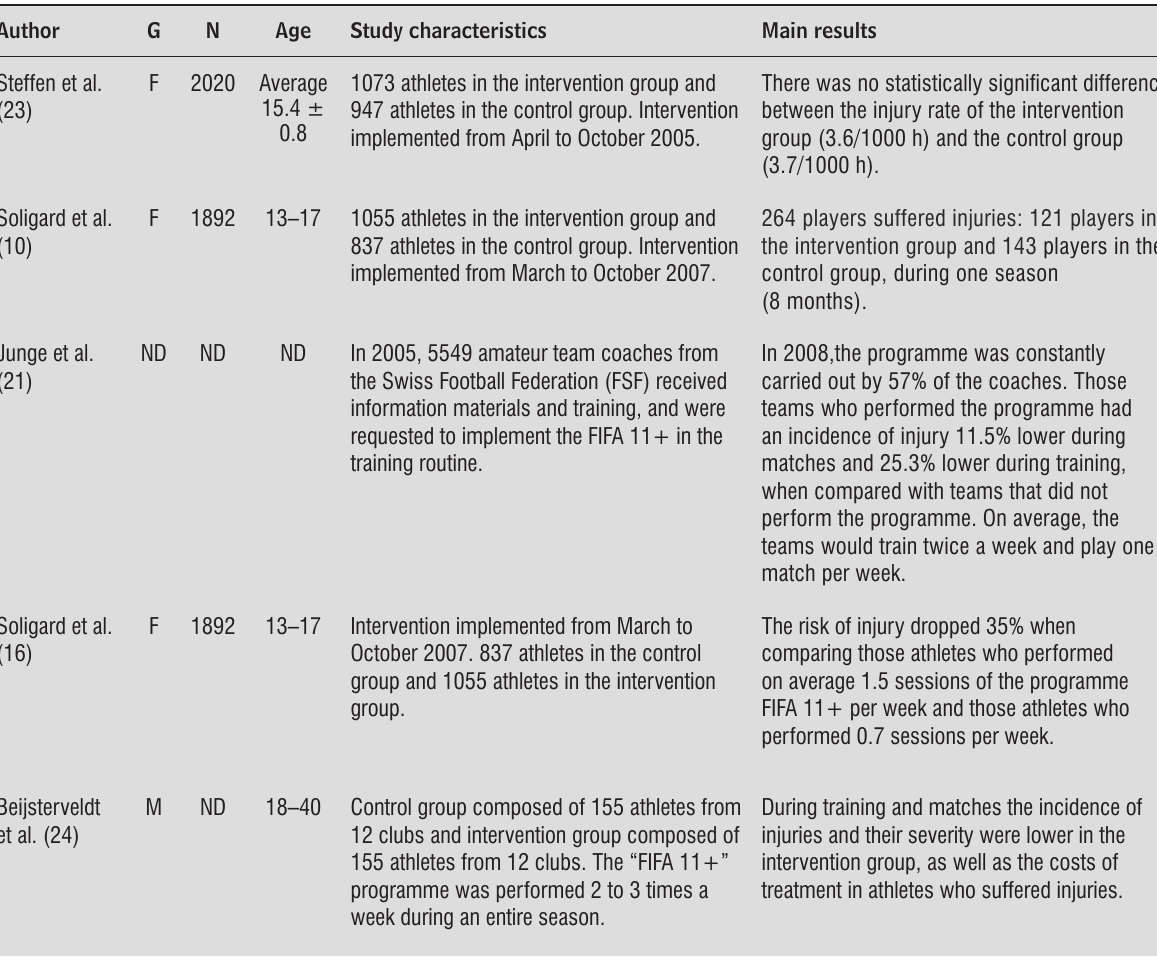
Table 1 - Summaries of the articles and their results based on reports about the possible effects of FIFA 11+ warm-up programme